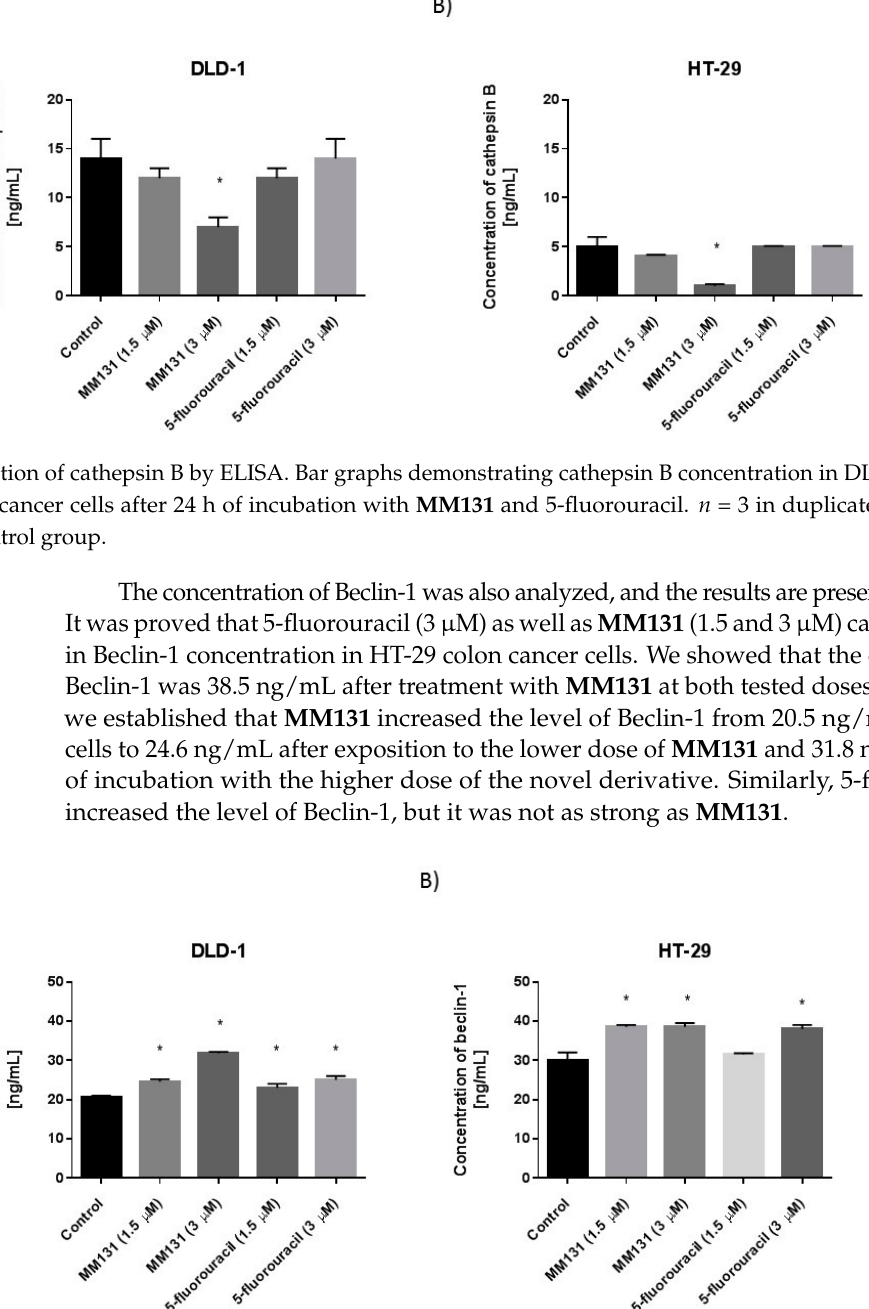
Figure 12. Quantification of Beclin-1 by ELISA. Bar graphs demonstrating Beclin-1 concentration in DLD-1 ( A ) and HT-29 ( B ) colorectal cancer cells after 24 h of incubation with MM131 and 5-fluorouracil. n = 3 in duplicates; * p < 0.05 versus respective control